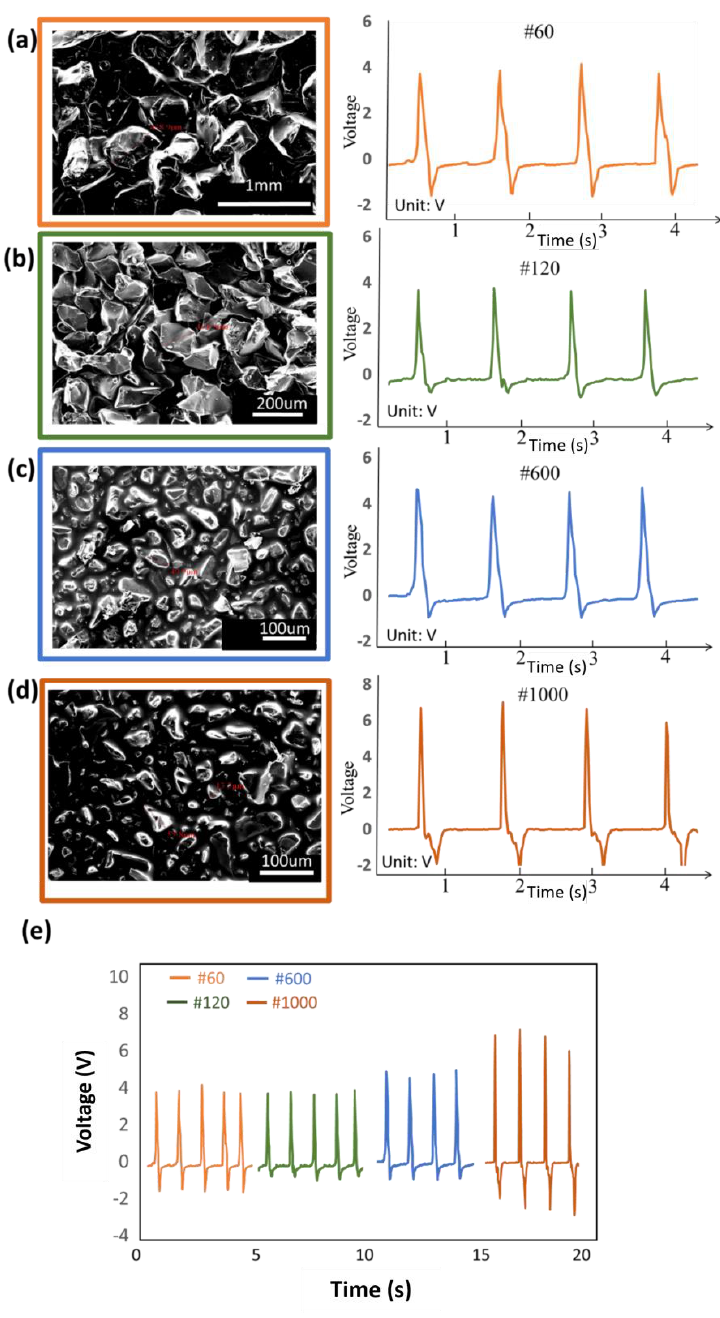
Figure 3. ( a ) Scanning electron microscope (SEM) image of 60 grit sandpaper and the voltage output test in the TENG. ( b ) 120 grit sandpaper SEM image. ( c ) Micromorphology of 600 grit sandpaper with the voltage output test. ( d ) 1000 grit sandpaper SEM image and the voltage output test. ( e ) Particle size comparison of the voltage output with different microstructures and surface